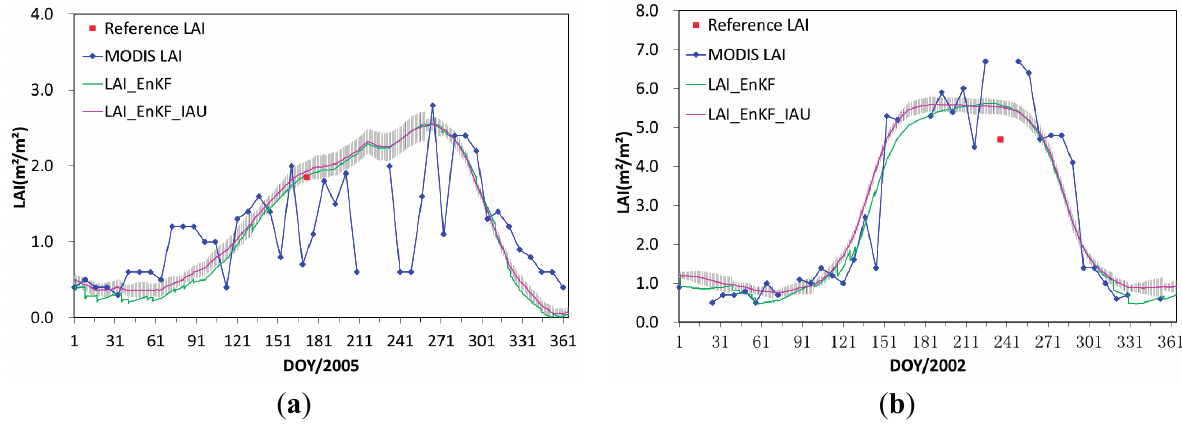
Figure 4. Retrieved LAI profiles by the inversion method with IAU at the center pixel of ( a ) the Donga site in 2005 and ( b ) the Harvard site in